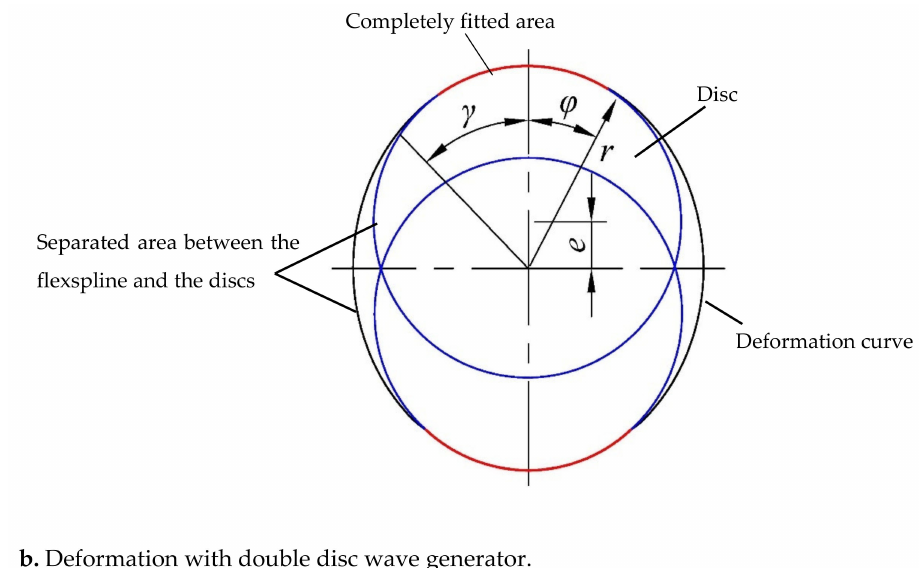
Figure 1. Two typical types of wave generator with free deformation. Adapted from ref. [24].